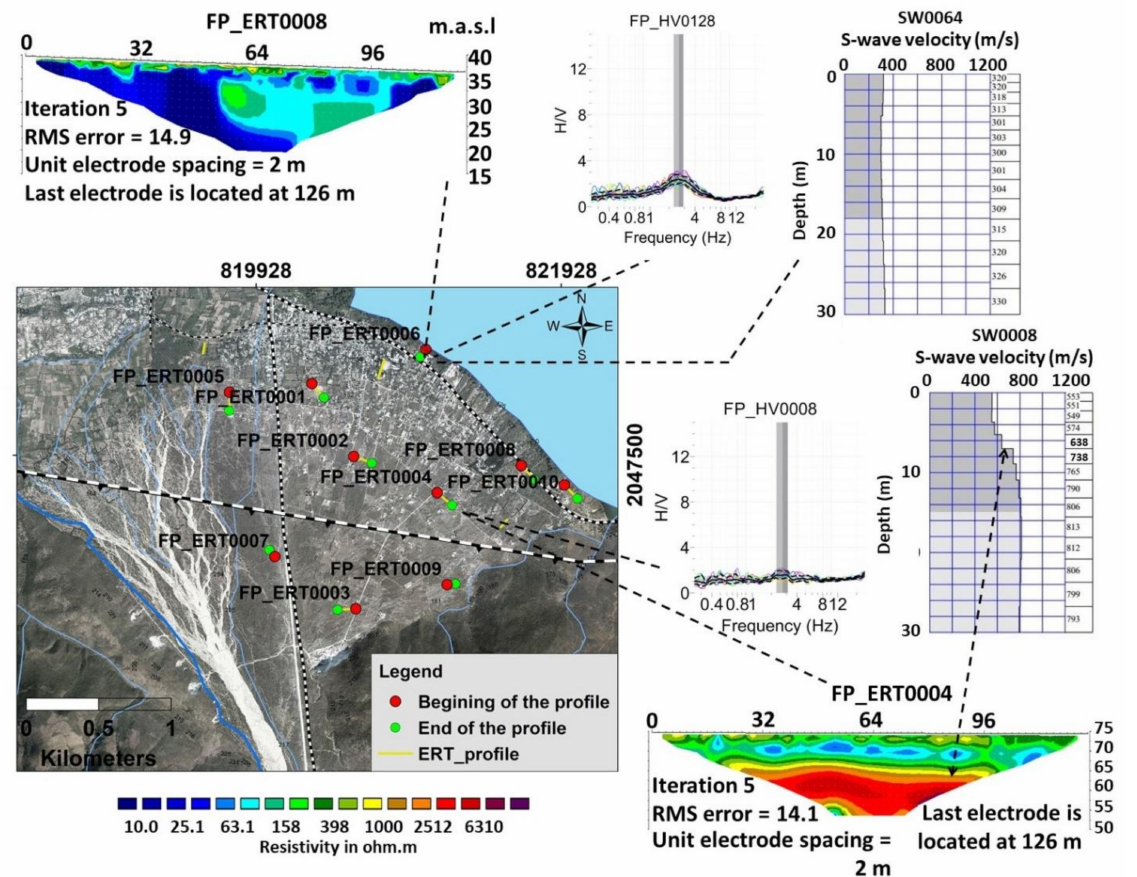
Figure 14. Comparison between ERT and MASW results for measurements completed on the lower part of the alluvial fan, near Lake